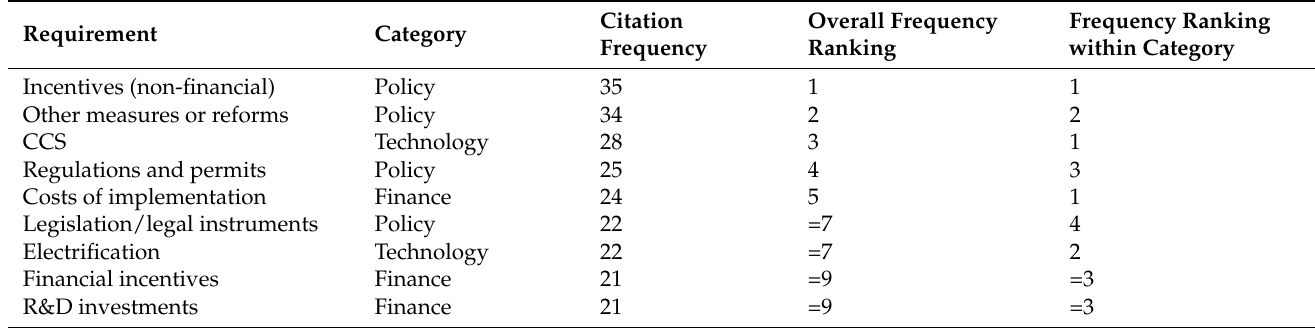
Table 3. Most prominent requirements (source: author’s